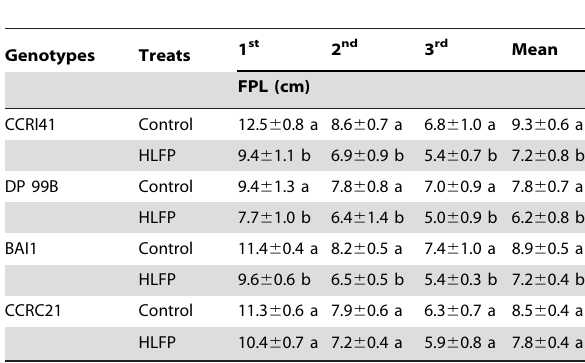
Table 3. Effects of mechanical stress caused by hanging labels from the petioles (HLFP) of every white flower in the field on the fruiting position lengths (FPL values) for four cotton